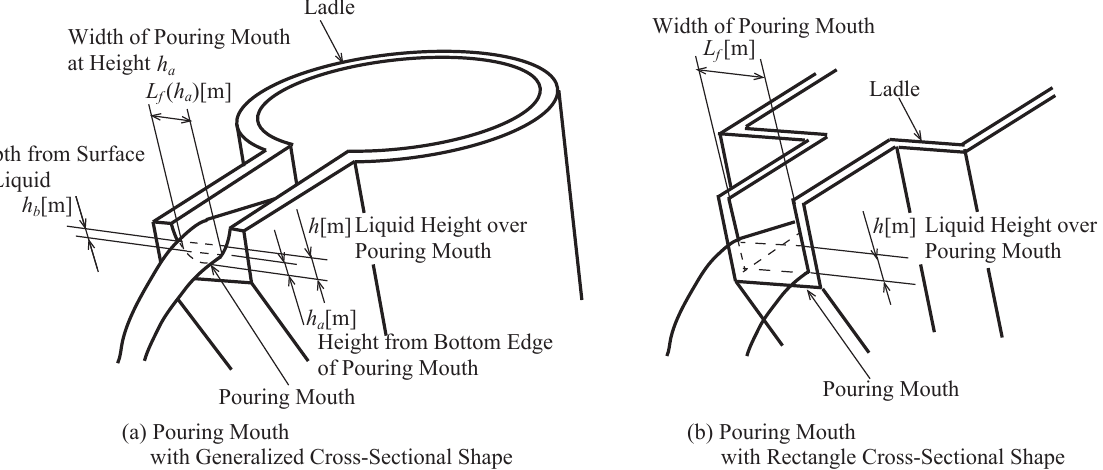
Figure 4. Parameters on pouring